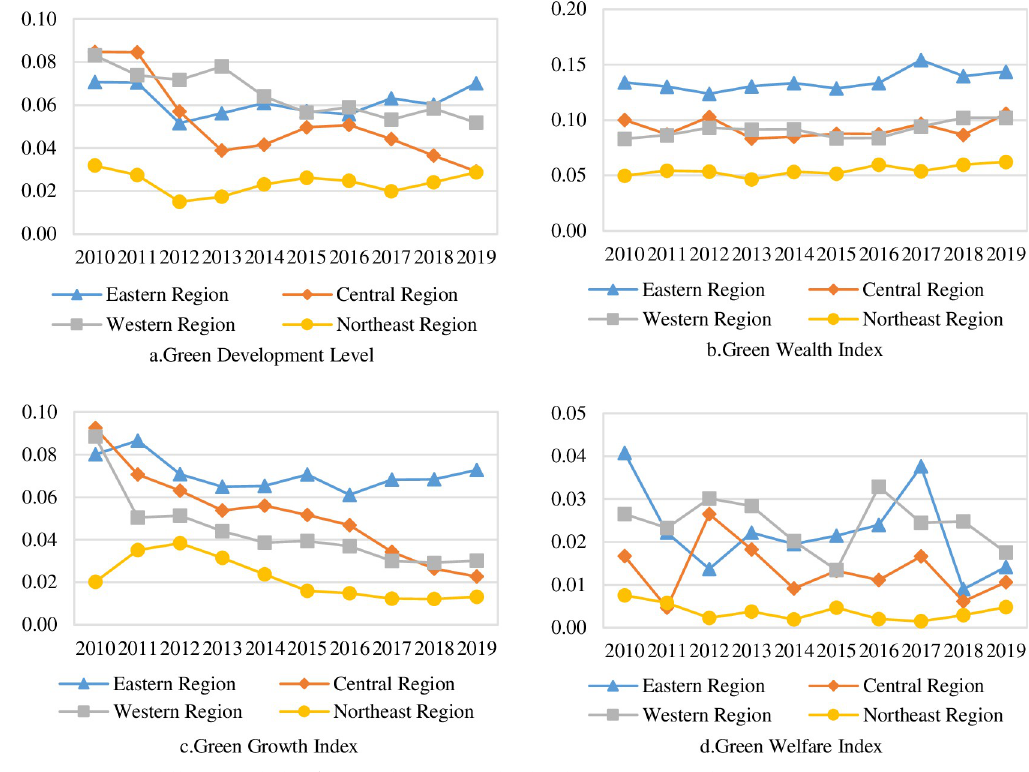
Fig 5. Regional differences of China’s green development level and its composition from 2010 to